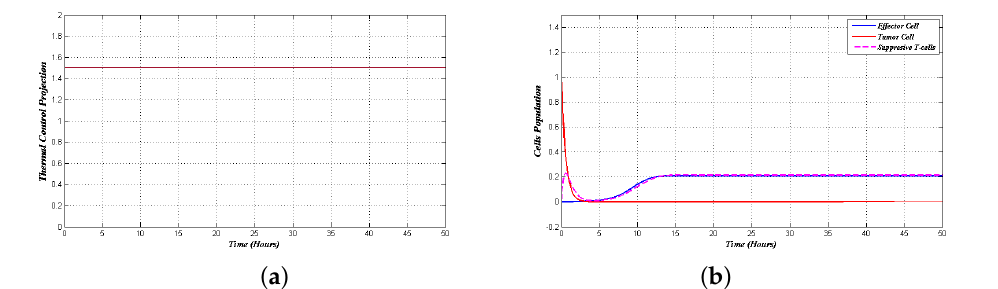
Figure 4. Numerical result For thermal optimal control when σ ≤ ¯ H ≤ Φ (Moderate heat induction). ( a ) Thermal control projection ( b ) Cell